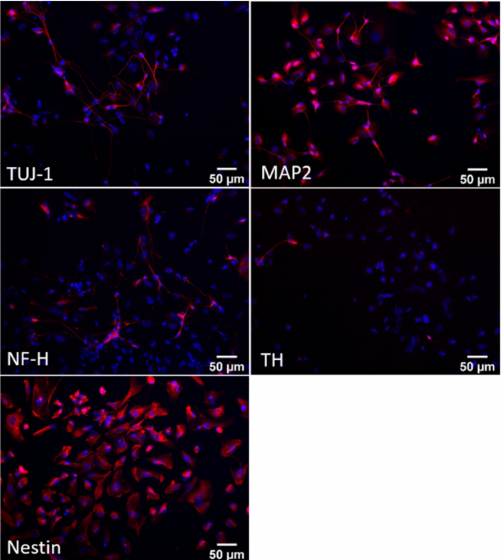
Figure 3. Characterisation of iPSCs differentiated for 24 days into dopaminergic neurons. Repre- sentative immunofluorescence images of human iPSC-derived dopaminergic neurons at day 24 of differentiation. Cells were stained (red) for the neuronal markers β -III-tubulin (TUJ1), neurofilament H (NF-H), microtubule-associated protein 2 (MAP2) and tyrosine hydroxylase (TH) and for the neu- ronal precursor marker nestin. Cell nuclei were stained with Hoechst (blue). Images were acquired at 200 × magnification.